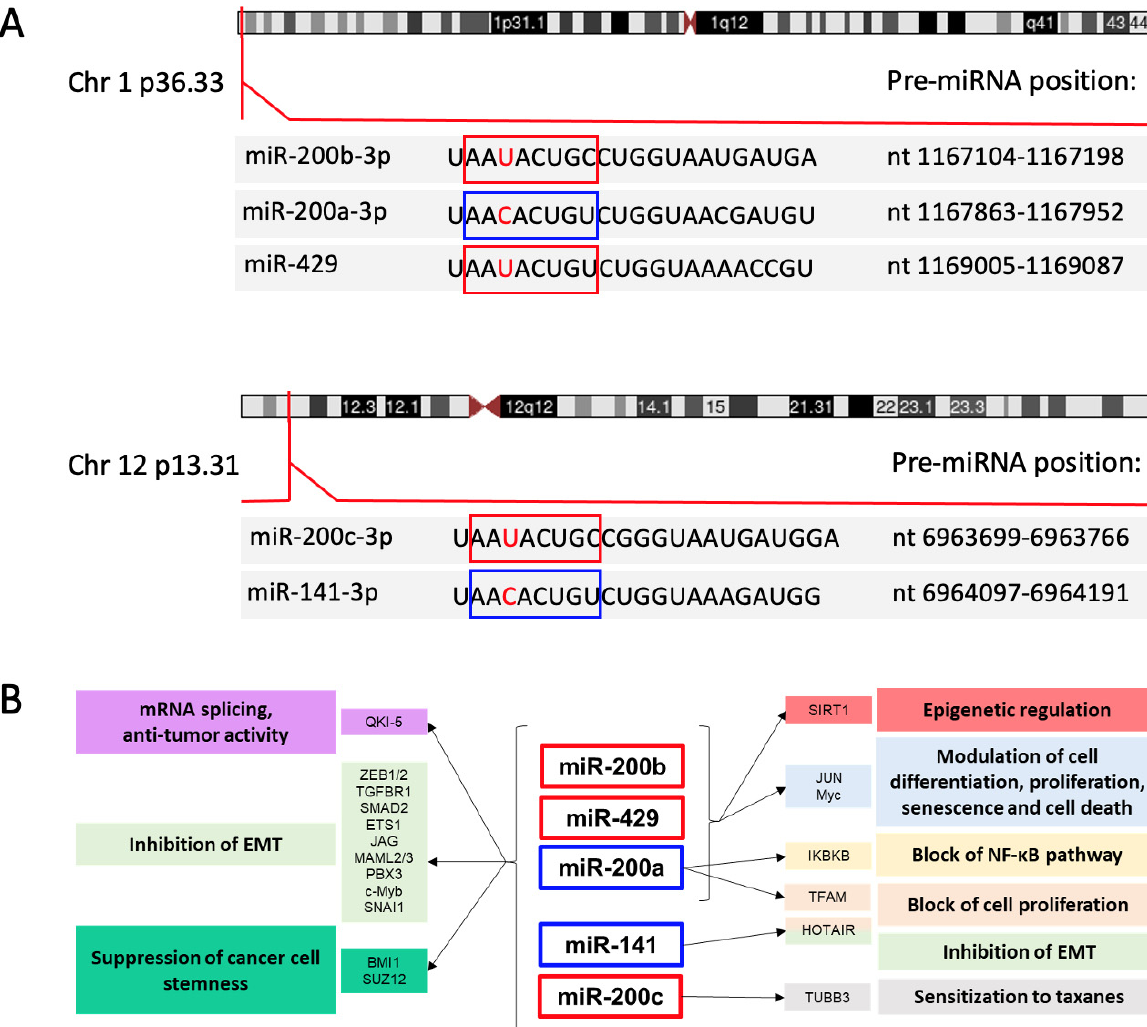
Figure 1. Genetic organization of the miR-200 family in humans. ( A ) Indicated are the chromosome loci encoding the two clusters of the miR-200 family, the positions of the pre-miRNA hairpins, and the sequences of the mature miRNAs with seed sequences highlighted in boxes. The seed sequences differ by one nucleotide (indicated in red). As described in the text, there is a strong bias for production of the -3p products from the pre-miRNAs. Information is from the Sanger miRbase (https://www.mirbase.org, accessed on 28 July 2021) [12] and https://genome.ucs.edu/index.htlm (accessed on 11 October 2021) University of California Santa Cruz Genome browser. ( B ) Schematic representation of the main targets and pathways controlled by the miR-200 family members grouped according to their genomic clusters. Red and blue boxes indicate the miRNAs with the two different seed sequences. A selection of target genes and corresponding biological effects are indicated using matching colors.